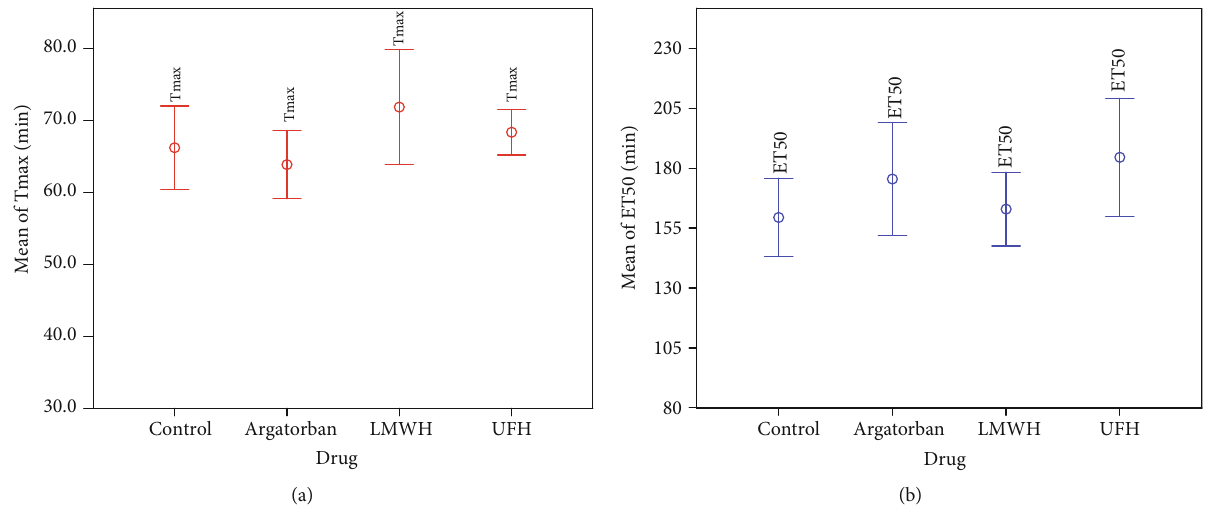
Figure 3: Neither the response of oxidized DHR nor the time course of DAPI-free DNA complex formation showed statistically signi fi cant mean di ff erences between the four groups. NET-forming (ET , blue) and ROS production (Tmax, red). LMWH: low-molecular-weight 50 heparin; UFH: unfractionated heparin.